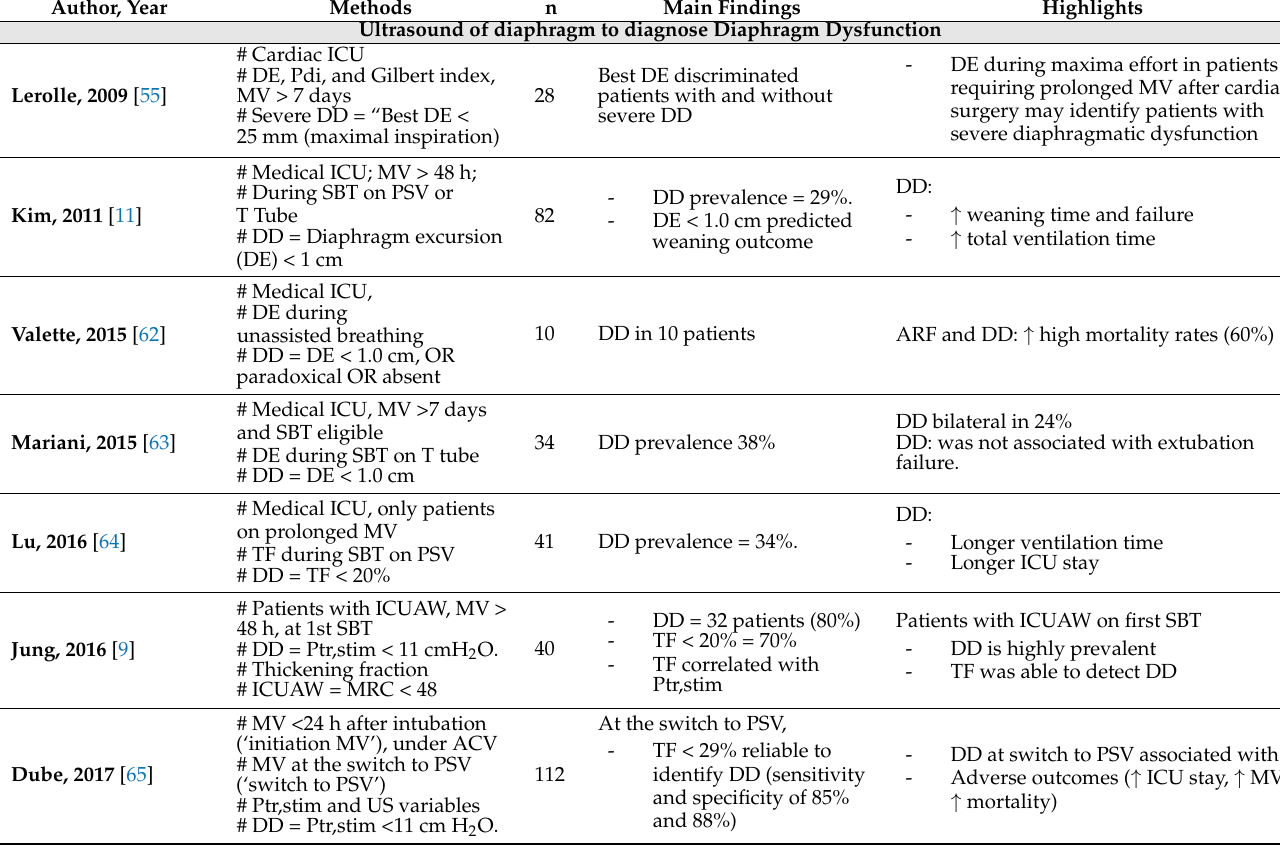
Table 1. An overview of recent evidence on diaphragmatic and intercostal ultrasound